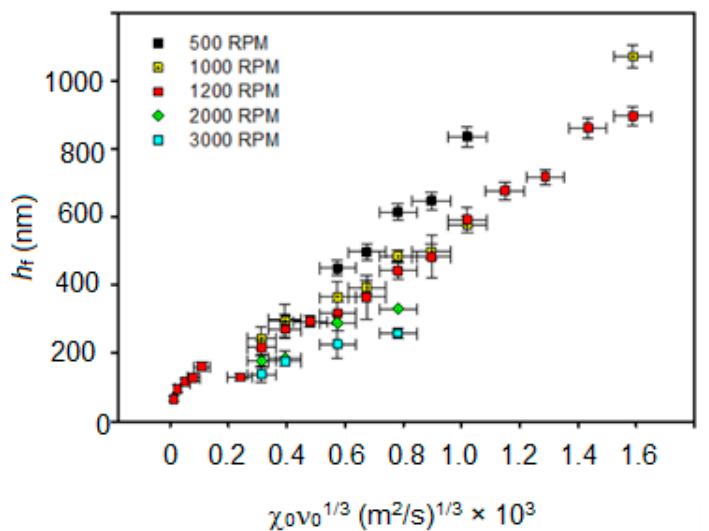
Figure 6. Film thickness as a function of the casting solution properties, per Equation (4). χ o is the polymer concentration (mass fraction) and ν 0 is the kinematic viscosity. Error bars are the standard deviation of at least 3 measurements per point.